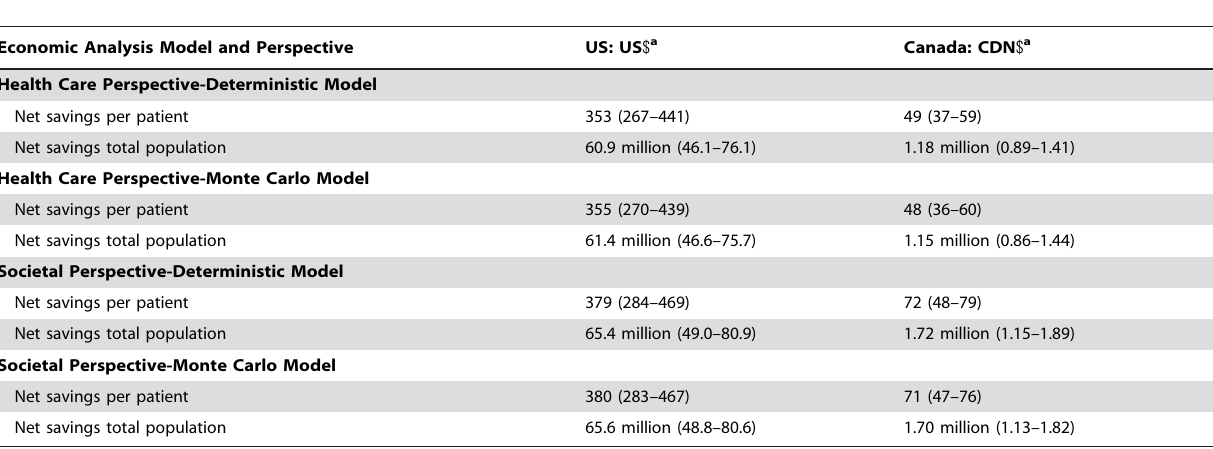
Table 3. Cost analysis of ondansetron administration to children with vomiting and dehydration secondary to acute gastroenteritis who are treated in an